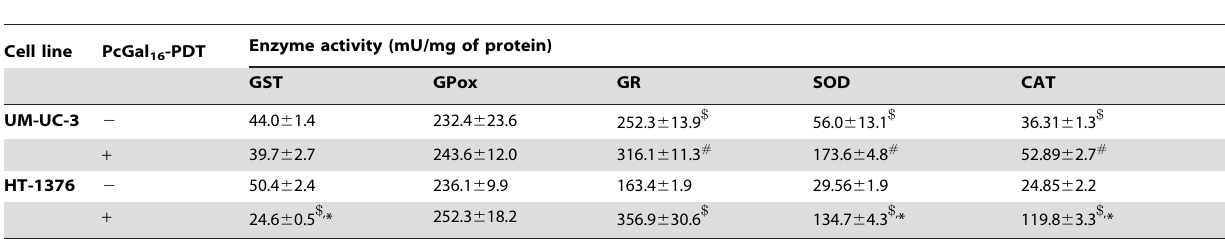
Table 2. Values of activity (mU/mg of protein) of antioxidant enzymes superoxide dismutase (SOD), catalase (CAT), glutathione peroxidase (GPox), glutathione reductase (GR) and glutathione S-transferase (GST) determined after PDT.